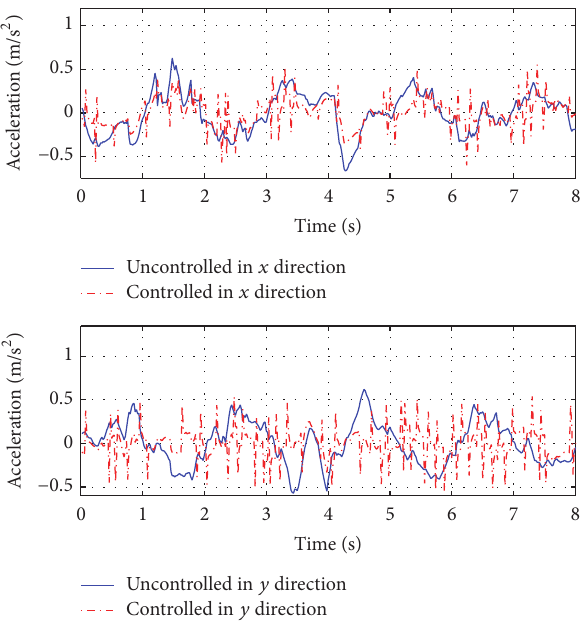
Figure 12: Acceleration responses of the tower turret under earth- quake.